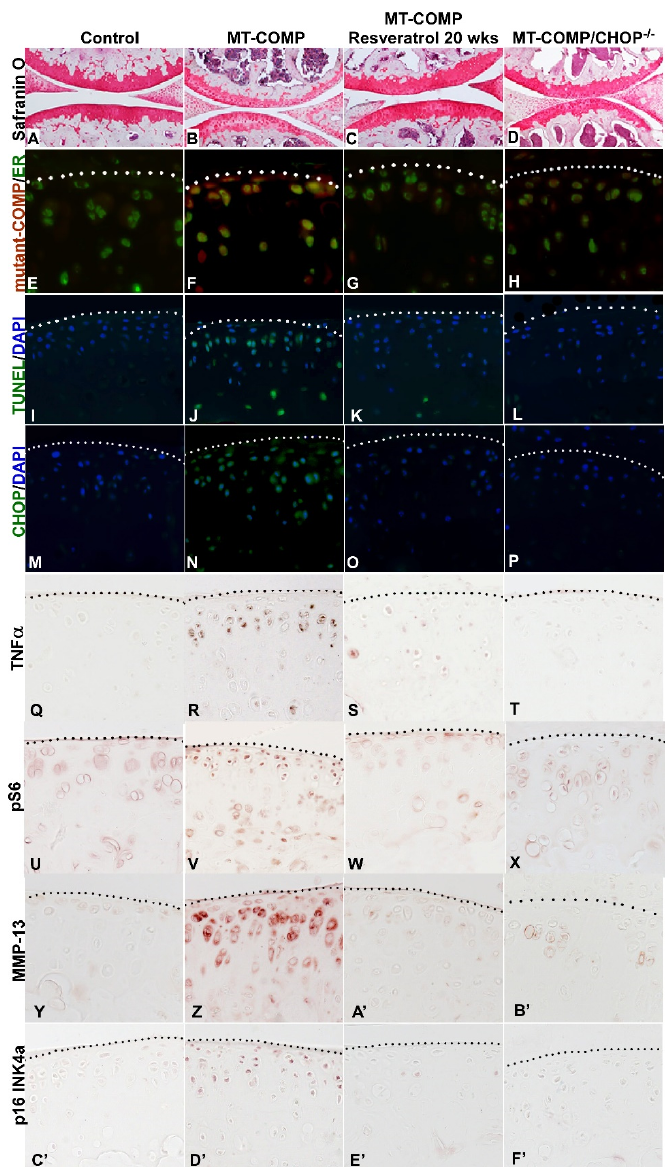
Figure 6. Articular cartilage of MT-COMP mice is preserved with resveratrol treatment or CHOP ablation. DOX was administered to all mice and resveratrol treatment to one group of MT-COMP mice ( C , G , K , O , S , W , A’ , E’ ) from birth to 20 weeks. Dotted line marks the edge of articular cartilage. All articular cartilages were stained with safranin O (red/pink A – D ) or immunostained using human COMP-specific antibodies (red, E – H ) and protein disulfide isomerase (PDI), an ER marker (green, E – H ), or TUNEL (green, I – L ) and DAPI (blue nuclei, I – L ), CHOP (green, M – P ER stress marker) and DAPI (blue, nuclei M – P ), TNF α (brown Q – T ), pS6 (brown U – X ), MMP13 (brown Y – B’ ), or p16 INK4a (brown C’ – F’ ). Safranin O staining shows that MT-COMP articular cartilage has less proteoglycans ( B ) compared to the control ( A ), and both resveratrol treated and ablation of CHOP normalizes proteoglycan content ( C , D ). TUNEL positive MT-COMP articular chondrocytes in ( J ) are more numerous than in the control ( I ), resveratrol treated ( K ), or MT-COMP/CHOP − / − ( L ). TNF α inflammation is decreased in resveratrol treated ( S ), or MT-COMP/CHOP − / − ( T ) articular chondrocytes compared to MT-COMP (R). mTORC1 signal activity (pS6) is detected in MT-COMP mice ( V ) compared to the controls ( U ), resveratrol treated MT-COMP ( W ), or MT-COMP/CHOP − / − ( X ) mice. Increased MMP-13 is present in MT-COMP ( Z ) articular cartilage compared to the controls ( Y ), resveratrol treated ( A’ ), or MT-COMP/CHOP − / − ( B’ ) mice. Senescent articular chondrocytes (p16 INK4a) were observed in MT-COMP mice ( D’ ), whereas a minimal p16 INK4a signal is seen in the controls ( C’ ), resveratrol treated ( E’ ), or MT-COMP/CHOP − / − ( F’ ). Bar = 100 µ